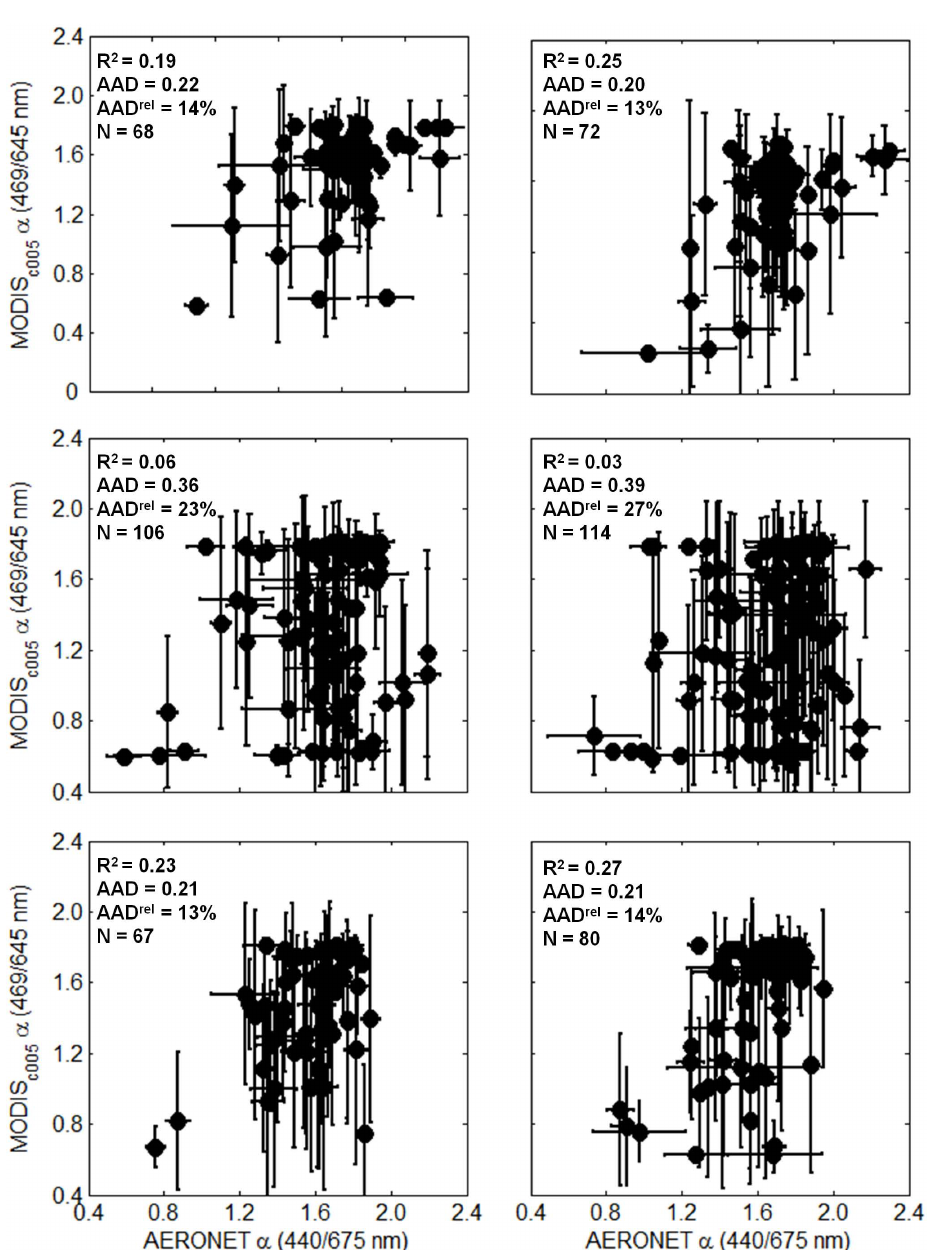
Fig. 5. Comparisons between MODIS c005 and AERONET α for the wavelength pairs 469/645 and 440/675nm, respectively, according to Aqua (left column) and Terra (right column) and period 1 (top panels), 2 (middle panels) and 3 (bottom panels). The explanation of abbreviations is given in Sect.